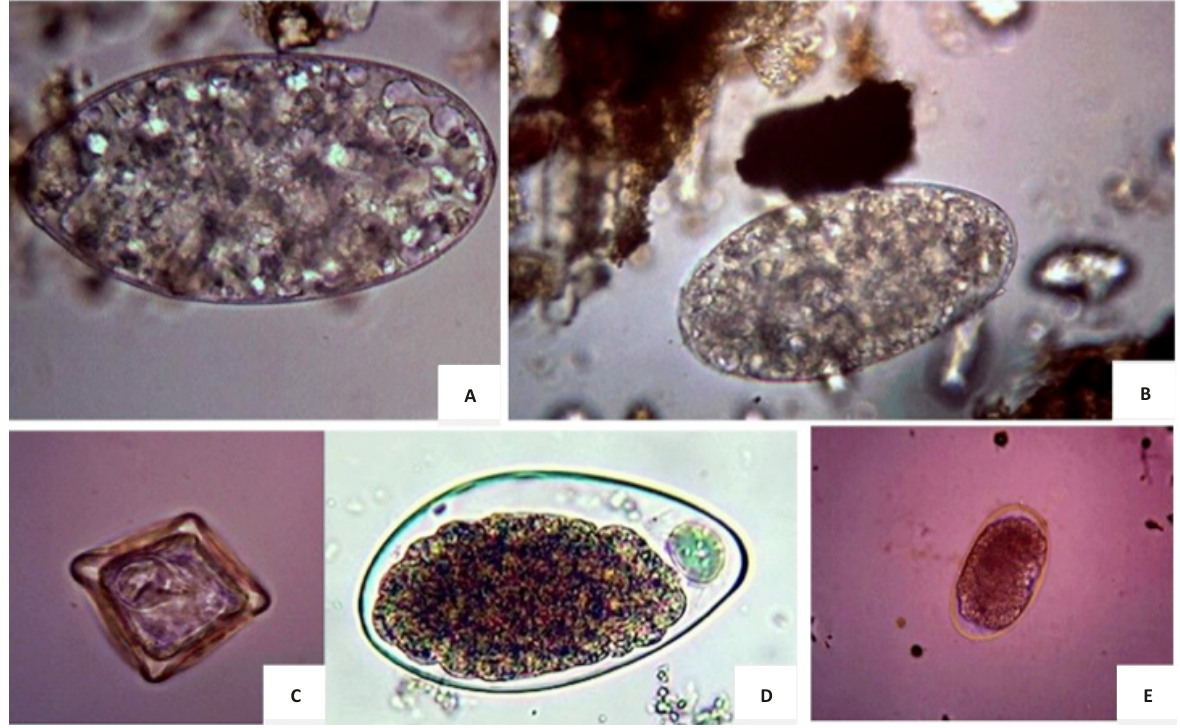
Image 2. Helminth eggs under microscope. Parasitic ova encountered during the study: A— Fasciola (10X)| B— Amphistome (10X)|, C— Moniezia (40X) D— Trichostrongyle (40X) | E— Strongyle